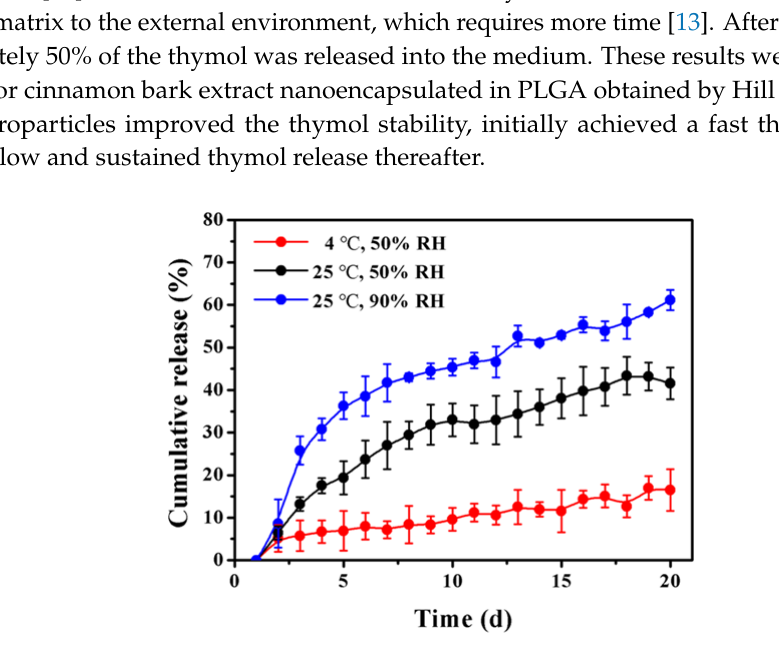
Figure 5. In vitro release of thymol from PLGA microparticles at 25 °C (50% RH), 25 °C (90% RH), and 4 °C (50% RH). Error bars indicate the standard deviation of the mean.